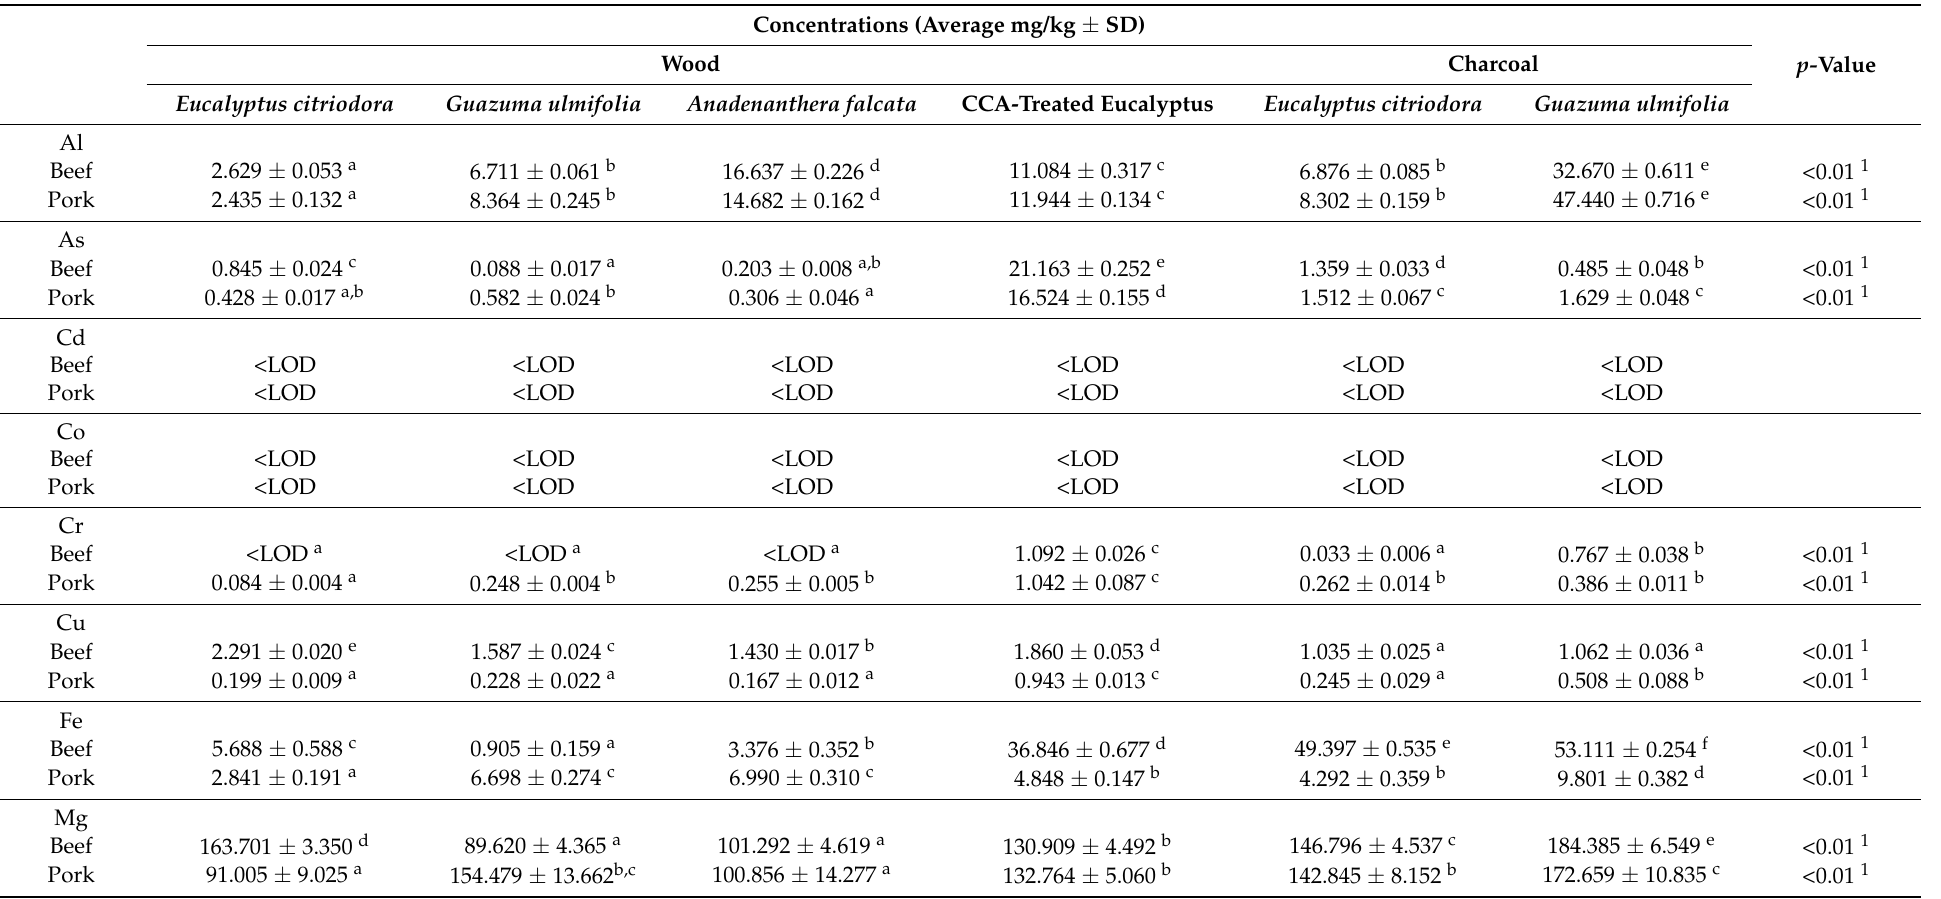
Table 2. Concentrations of chemical elements obtained from the difference between “roasted” animal tissue minus fresh raw